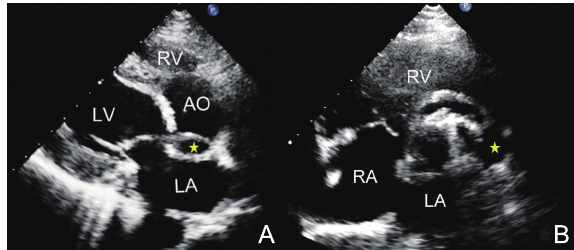
Figure 2 (A) and (B) showed echo-free space (yellow asterisk) around the aortic root. AO, aorta; LA, left atrium; LV, left ventricle; RA, right atrium; RV, right